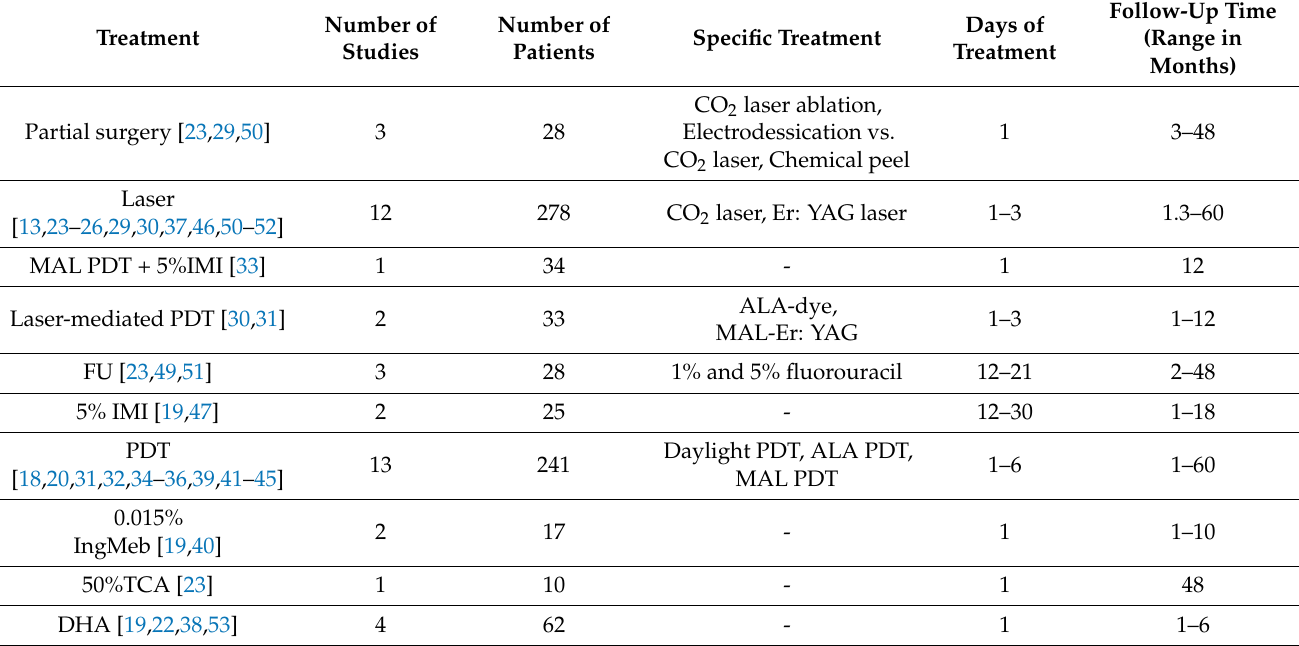
Table 1. Studies and therapeutic process per treatment